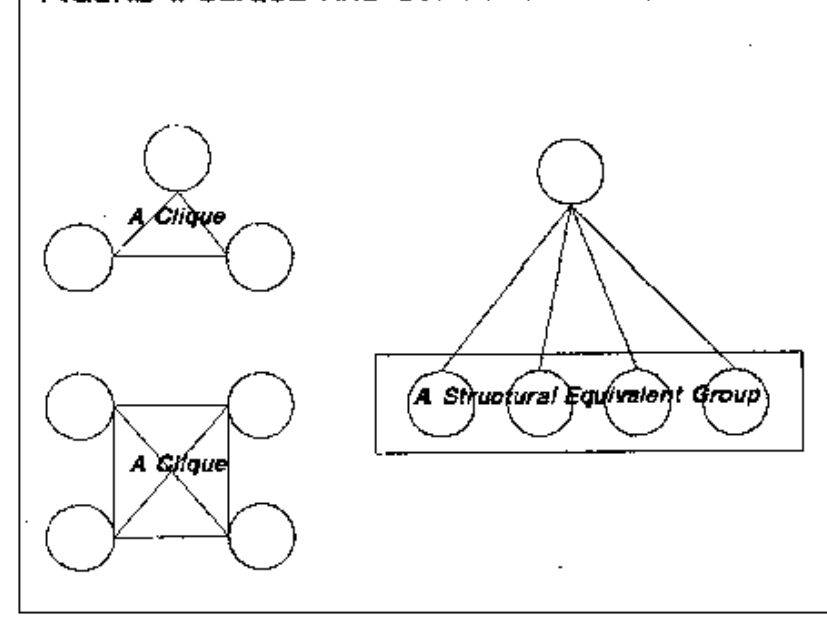
FIGURE 1: CLIQUE AND STRUCTURAL